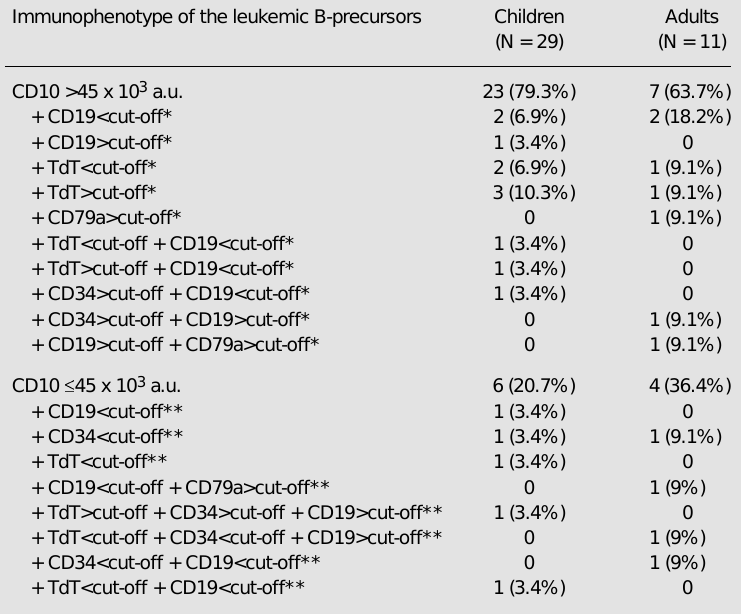
Table 5 - Frequency of CD10 + acute lymphoblastic leukemia cases expressing marker SABC values higher or lower than the cut-off values established for normal bone